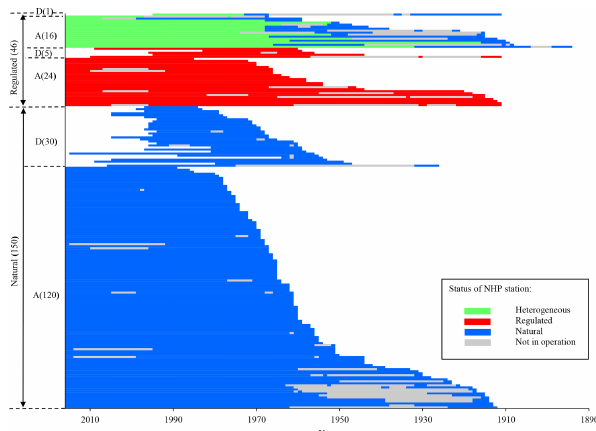
Figure 2. Bar chart showing the operational history of the 196 Na- tional Hydrometric Program (NHP) stations included in the Cana- dian River Ice Database. Stations are categorized by flow condition (natural or regulated), operational status (active, A, or discontinued, D) and flow condition (homogeneous or heterogeneous). The num- ber in each subcategory is shown